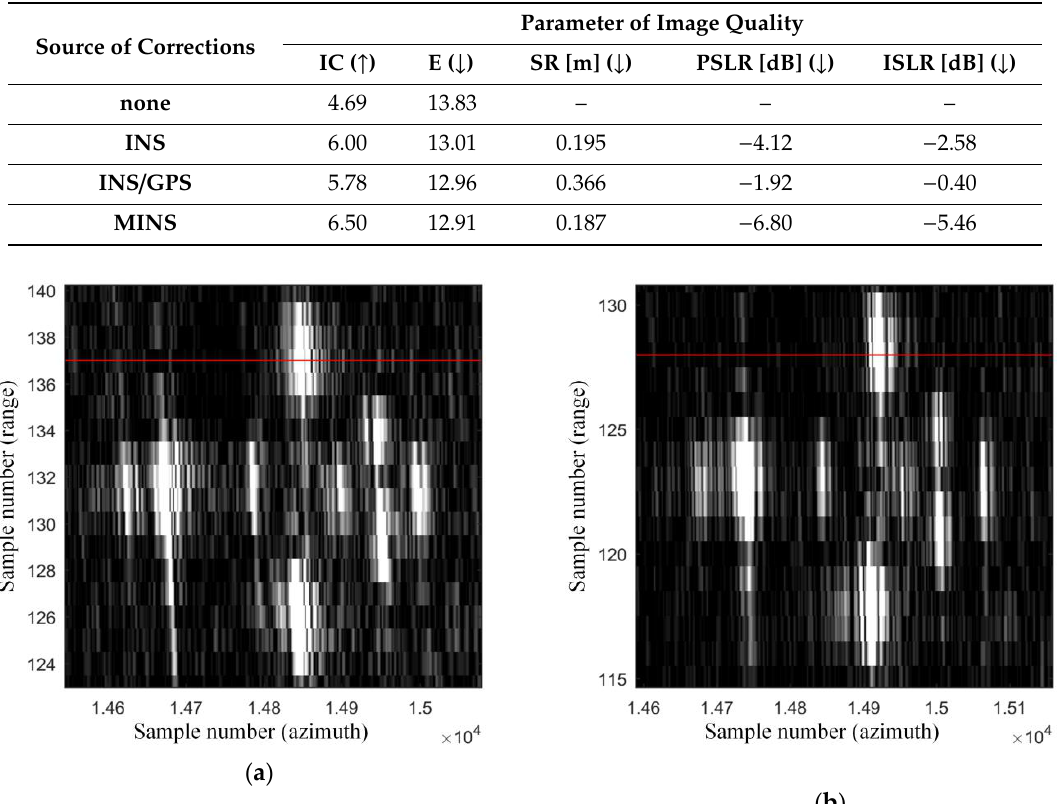
( a ) ( b ) Figure 22. Normalized amplitude of the selected corner reflector image: ( a ) with the INS-based MOCO, ( b ) with the MINS-based MOCO. 5. Conclusions The article discusses a method of calculating UAV navigation elements (position, velocity, and attitude) using the proposed multi-instance INS (MINS). The motivation for its development was the analysis of the pros and cons of the INS- and INS/GPS-based MOCO methods used in SAR algorithms and the search for a new method which profits from the advantages of existing MOCO procedures but avoids their drawbacks. The results obtained from the proposed MINS system are smooth, similar to the classical INS output. Moreover, thanks to the initialization of new INS instances, errors in MINS are kept at a low level, similar to the INS/GPS systems.